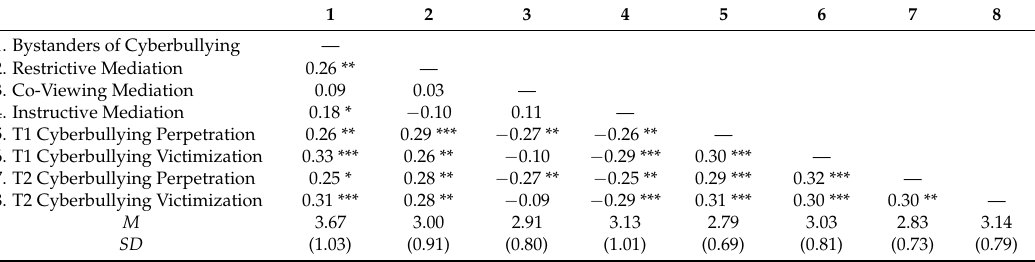
Table 1. Means, standard deviations, and correlations among